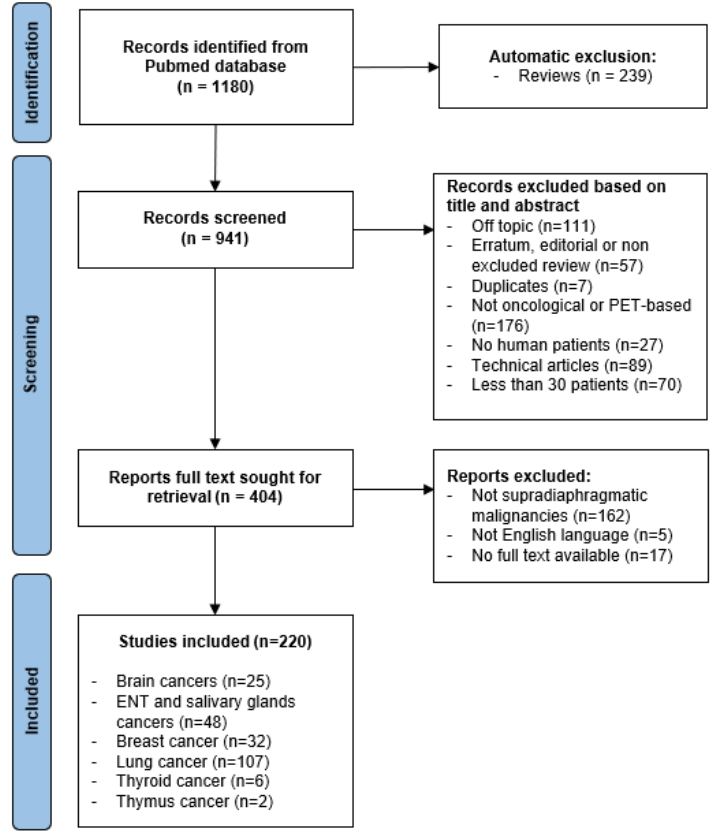
Figure 1. Flowchart of literature search and article selection.